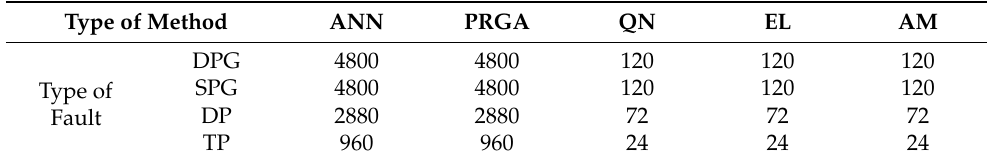
Table 8. Validation cases by fault type and